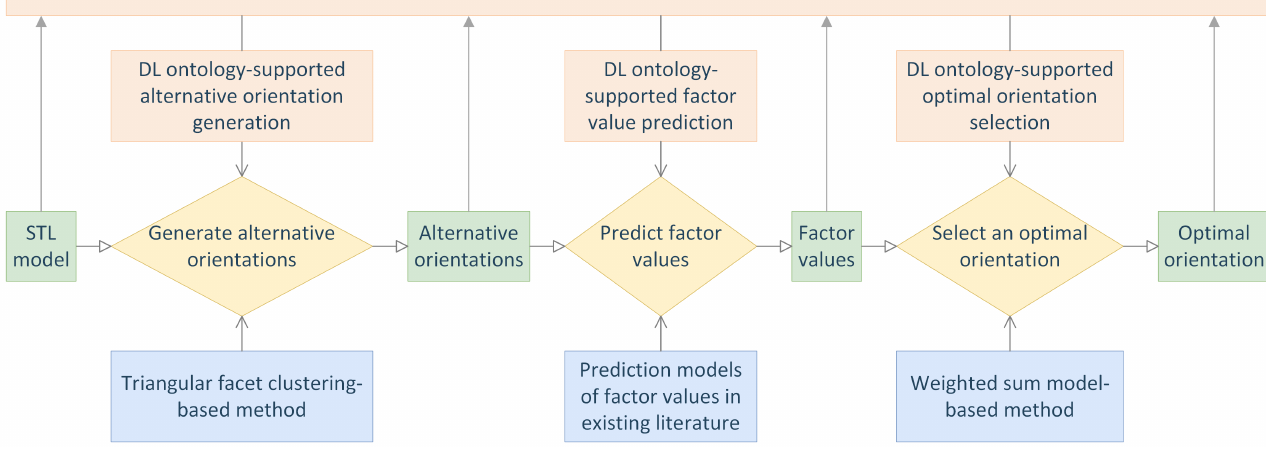
Figure 2. Schematic representation of the presented DL ontology-supported